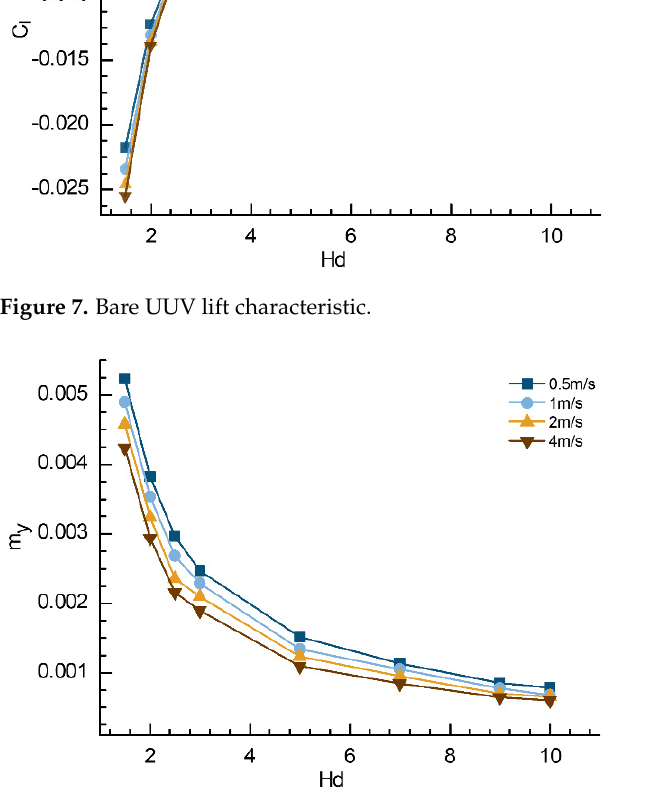
Figure 8. Bare UUV Pitch moment characteristics.